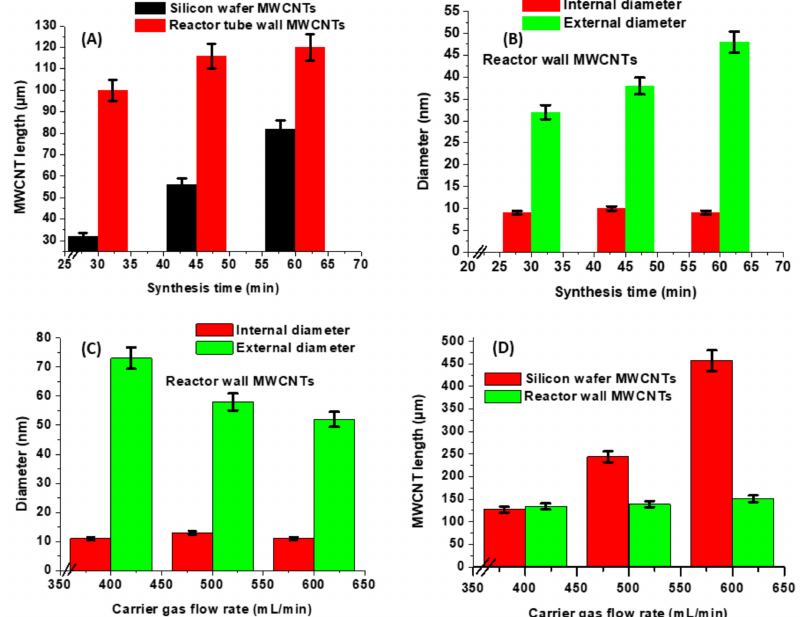
Figure 4. Synthesis parameters of MWCNTs. Synthesis time on the length or thickness of MWCNTs on both the silicon wafer (black column) and the reactor tube walls (red column) ( A ); synthesis time on both the MWCNTs internal (red column) and external (green column) diameters ( B ); carrier gas flow rate on both the MWCNTs internal (red column) and external (green column) diameters ( C ); carrier gas flow rate on MWCNTs length on both silicon wafer (red column) and reactor wall (green column) ( D ).